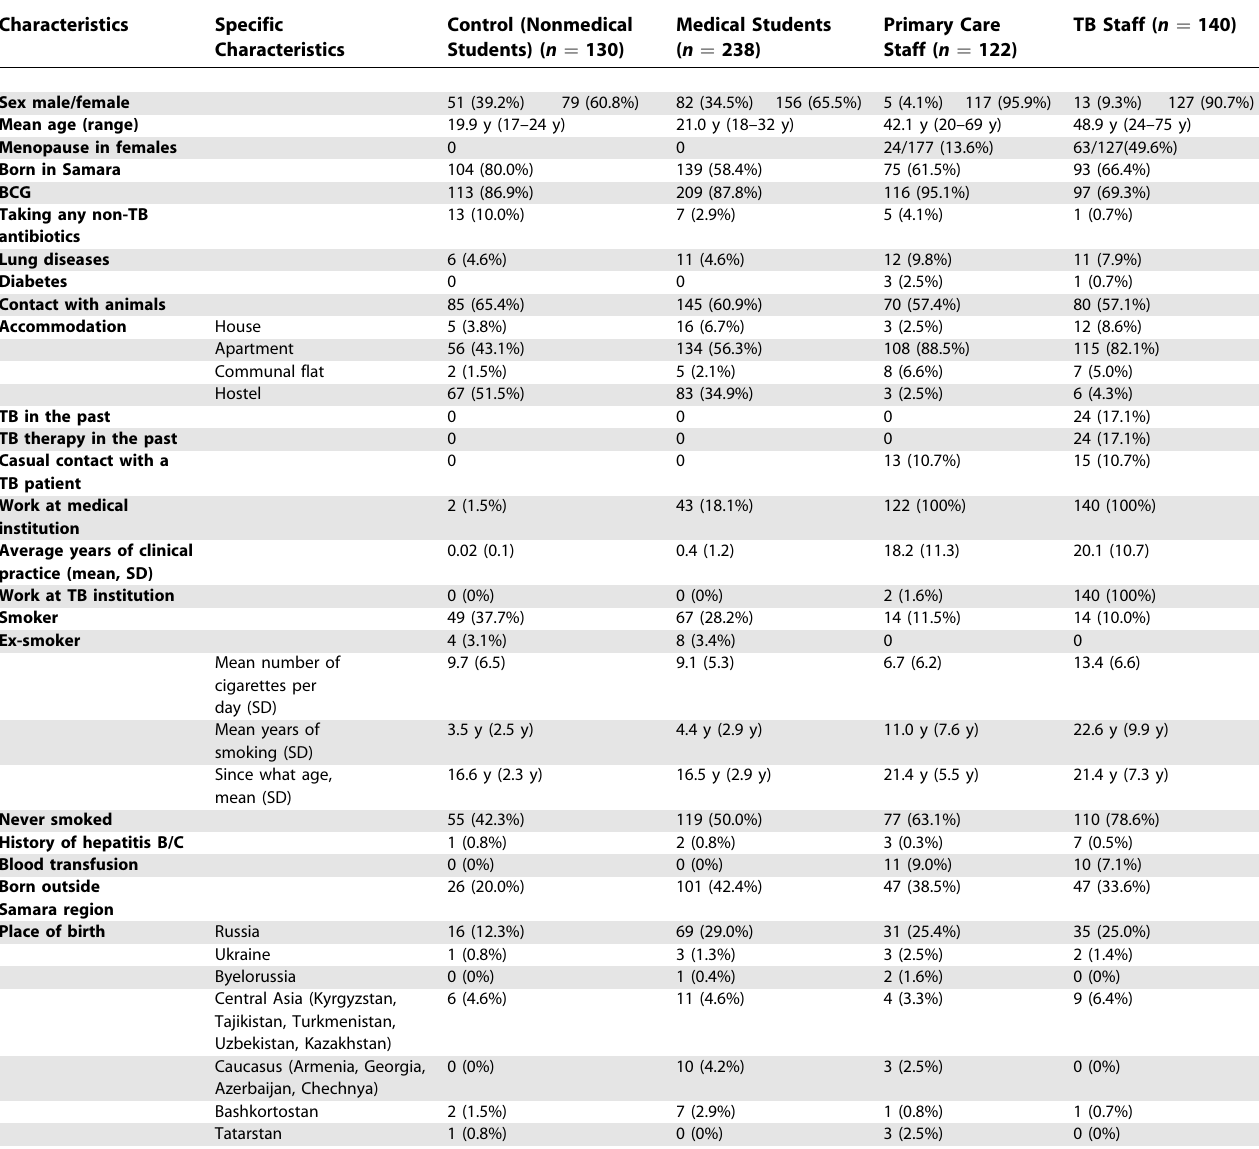
Table 1. Baseline Characteristics of Student and Health-Care Groups